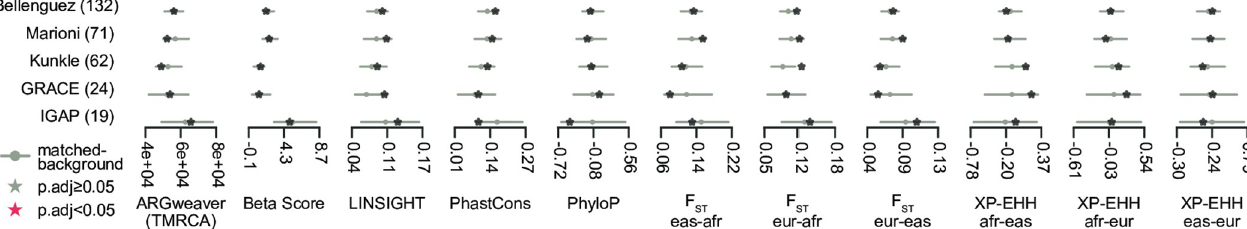
Fig 4. Loci for late-onset Alzheimer’s disease lack enrichment for evolutionary forces. Across five GWASs conducted on Alzheimer’s Disease (y-axis), we plot the trait-averaged value (red or black stars) across evolutionary measures (x-axis) compared to their matched genomic background values (gray bars, 5th, 95th percentiles. We did not find significant enrichment for any evolutionary measures (FDR < 0.05 with multiple testing correction, Methods). This pattern held across all five GWASs considered. This suggests that genomic regions contributing to the development of Alzheimer’s Disease are not enriched for specific evolutionary